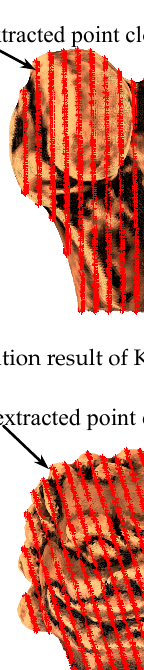
Figure 10. Chinese lion head model is a discretization example of T-splines, ( a ) the overall generated point cloud, ( b ) the partial magnification of point cloud.